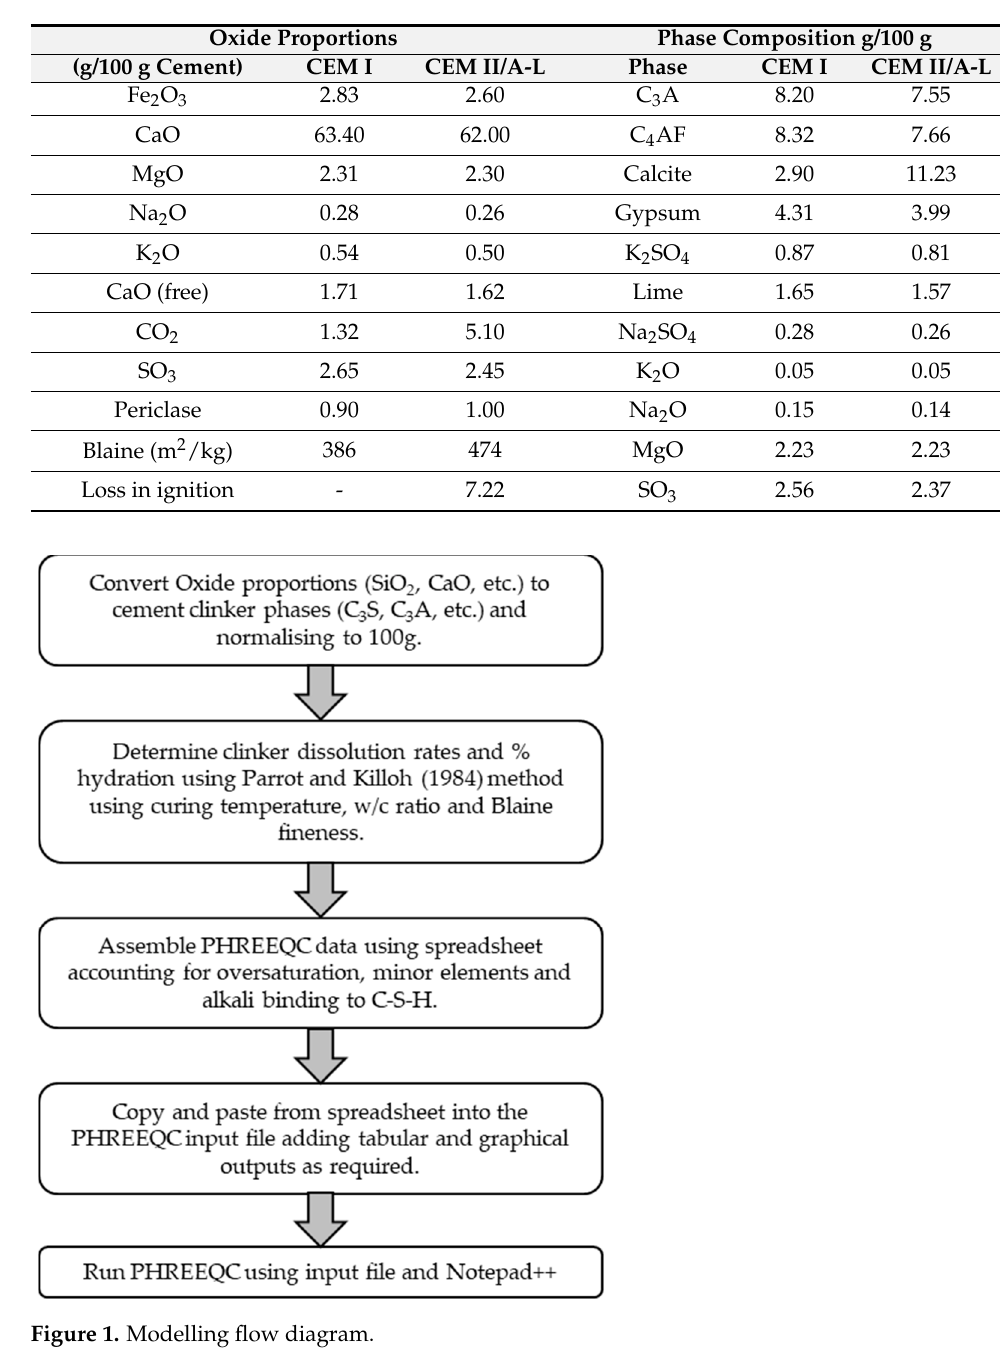
Table 1. Cement oxide proportions (from XRF) and clinker phase compositions. Table 1. Cont.